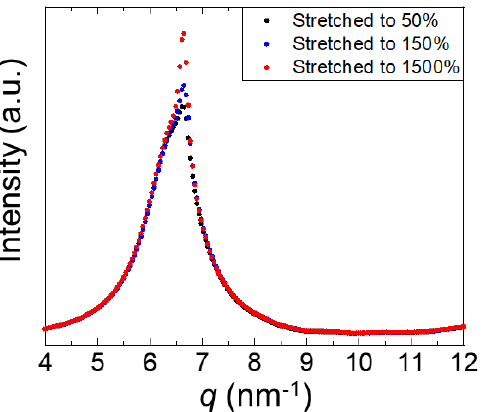
Figure 8. WAXS profile of PDEF after extension at 100 ◦ C for 50%, 150%, and 1500%. The q value